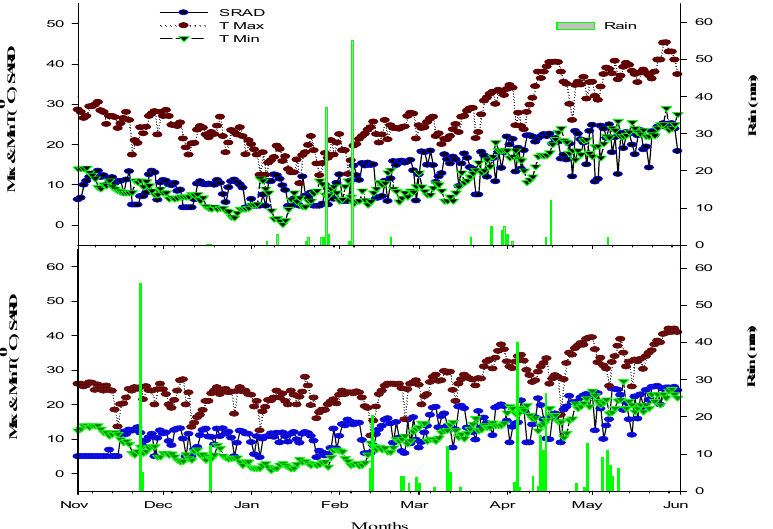
Figure 1. Daily total precipitation solar radiation and daily maximum and minimum temperature for experimental location during first ( upper graph ) and second growing seasons ( lower graph ).